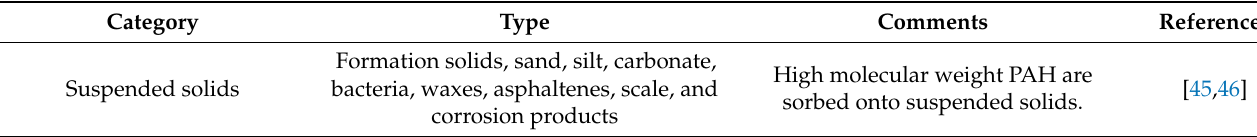
Table 1. Produced water